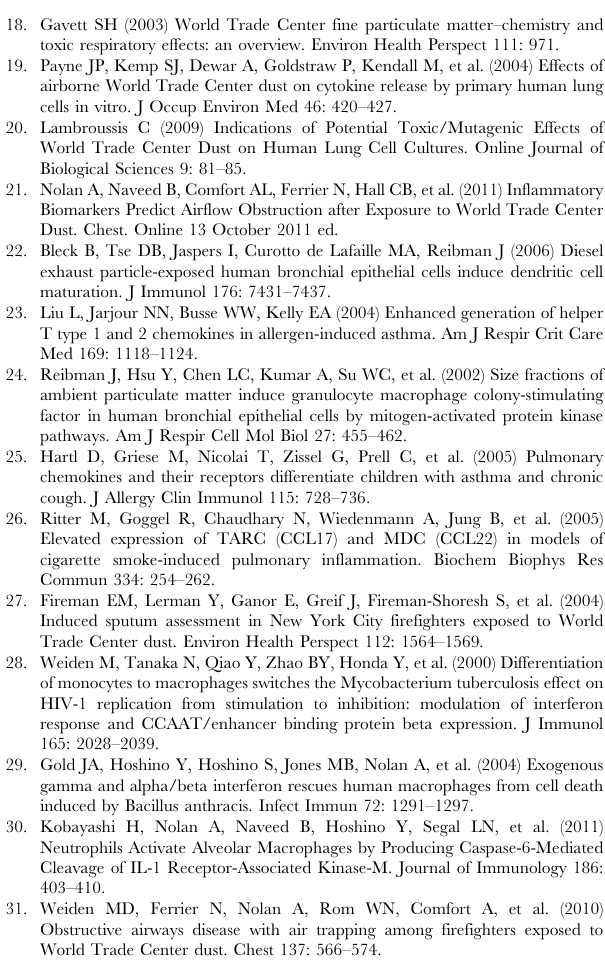
Table S1 Expression of Analytes by Alveolar Macro- phages for All Stimuli A. Baseline Analyte Expression Above Limits of Detection (LOD) B . Baseline Analyte Expression